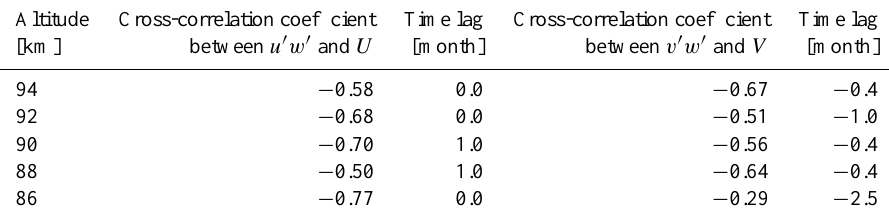
Table 2. Cross-correlation coefficient and time lag between momentum flux and mean horizontal wind at the height range of 86–94km at Koto Tabang. Altitude Cross-correlation coefficient Time lag Cross-correlation coefficient Time lag [km] between u (cid:48) w (cid:48) and U [month] between v (cid:48) w (cid:48) and V [month] 94 − 0.58 0.0 − 0.67 − 0.4 92 − 0.68 0.0 − 0.51 − 1.0 90 − 0.70 1.0 − 0.56 − 0.4 88 − 0.50 1.0 − 0.64 − 0.4 86 − 0.77 0.0